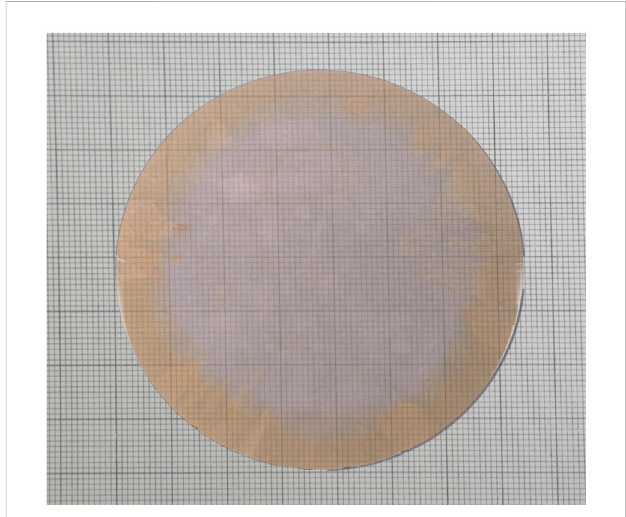
FIGURE 2 Φ 75 mm AlN polished sample wafer sliced from the Φ 76 mm AlN